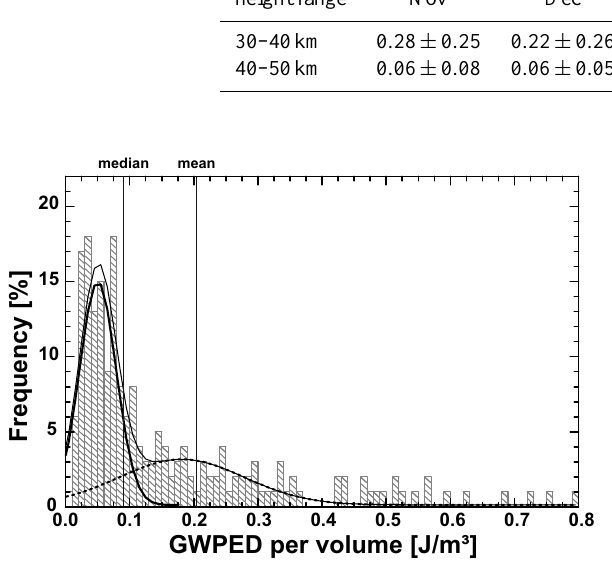
Figure 5. Histogram of the occurrence frequency of the GWPED per volume measured between November and March in the height range from 30 to 40km. Two Gaussian modes are fitted to the dis- tribution (thick and dashed line), while the thin line denotes the sum of the two